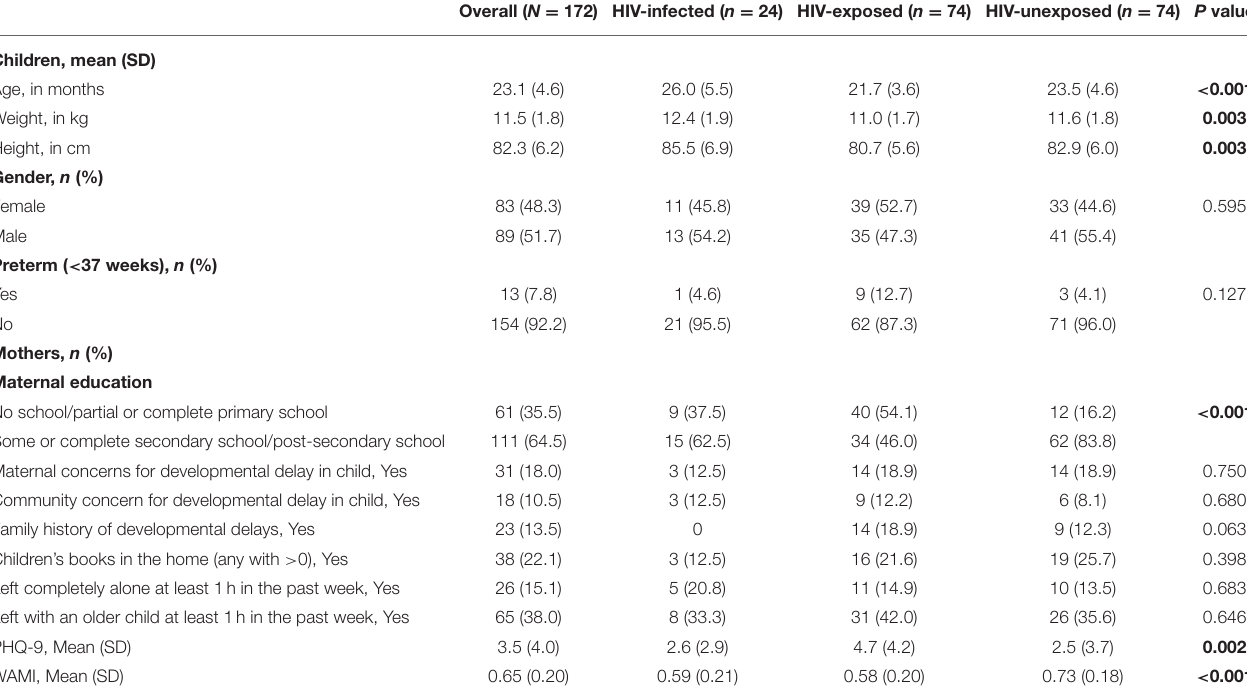
TABLE 1 | Characteristics of study population, recruited from a large referral hospital in western Kenya, at 18–36